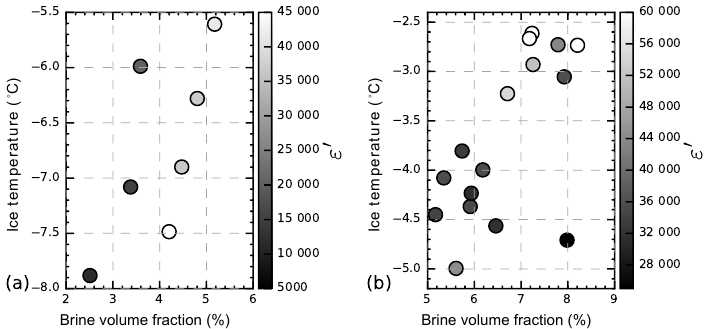
Figure 9. The influence of ice temperature and brine volume fraction on measurements of the real part of the complex permittivity ( ε (cid:48) ): (a) from 2.0 to 6.0% brine volume fraction; (b) from 5.0 to 9.0% brine volume